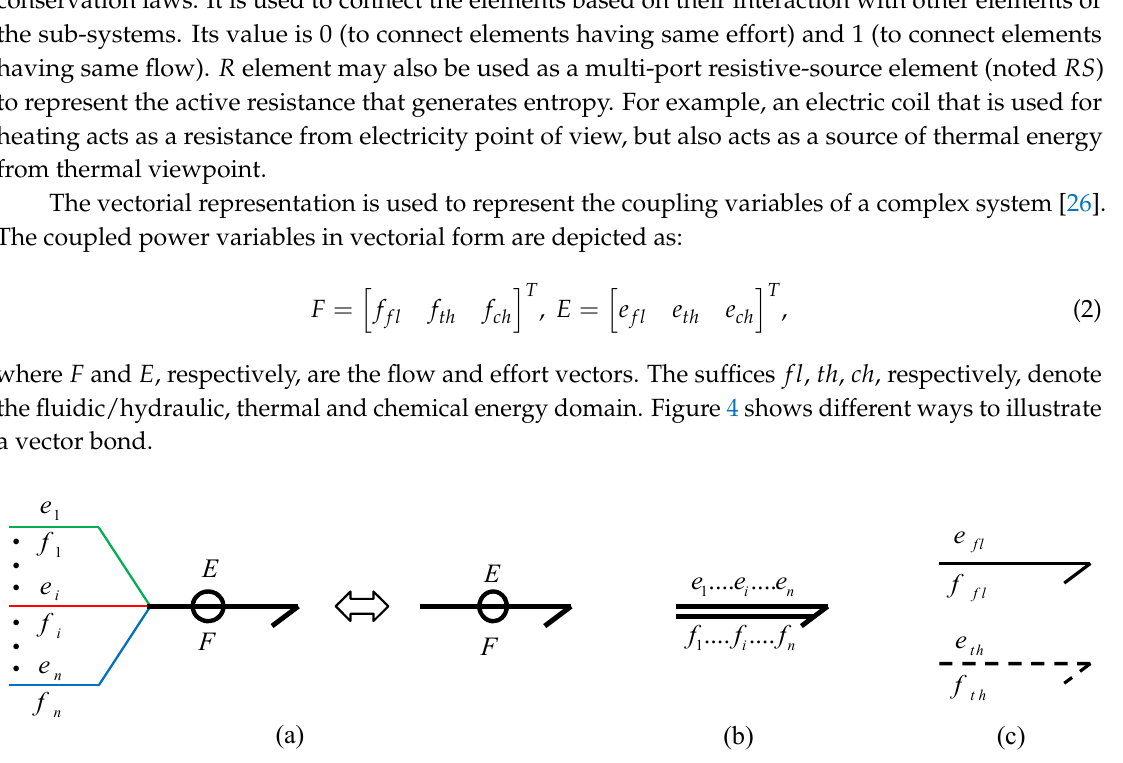
Figure 4. Representation of vector bond ( a ) with a small ring around the power bond, ( b ) with multi-bonds and ( c ) with separate power bond for different energy